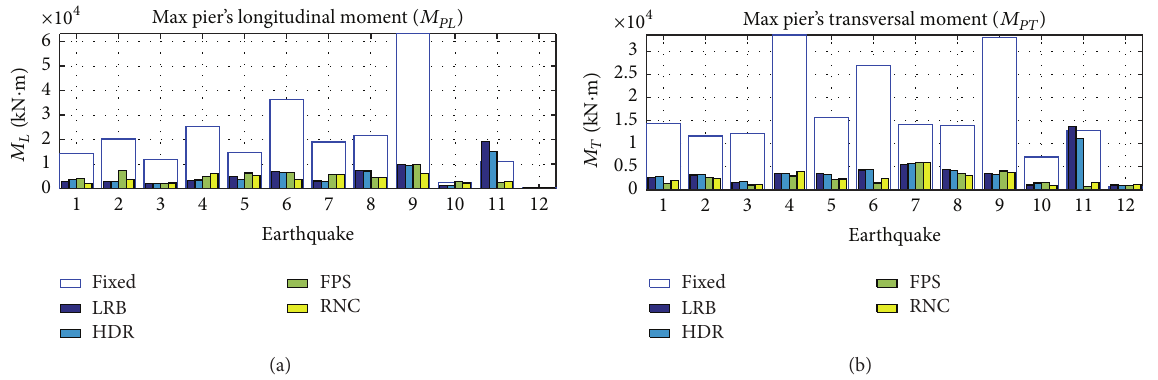
Figure 10: The pier’s column peak moments: (a) longitudinal moment; (b) transversal